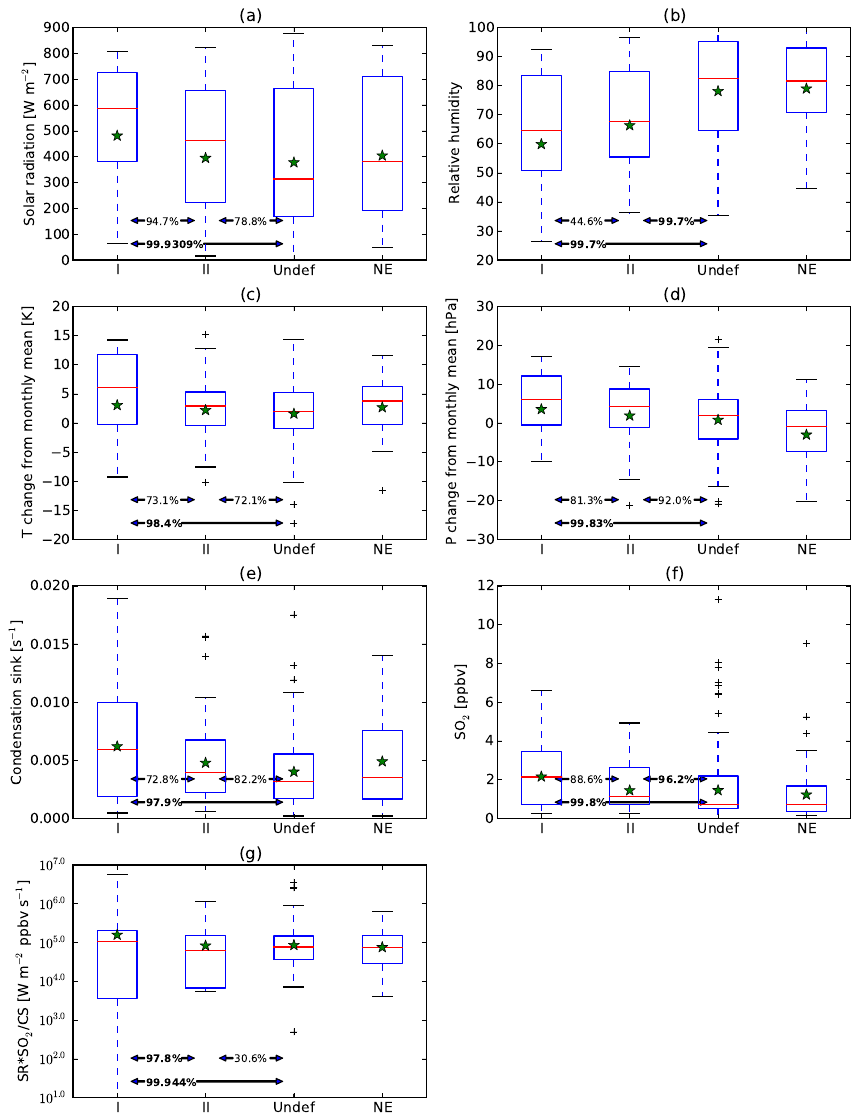
Figure 4. Box-and-whisker plots of various meteorological variables as well as the condensation sink, SO 2 mixing ratio and a H 2 SO 4 proxy for class I, II, undefined and non-event days. The values are calculated between the start and end of new-particle formation on each day except for non-event days where the full day is used. The red line shows the median values. Stars show the mean values. The box shows the interquartile range (IQR, 25th and 75th percentiles). The whiskers show the lowest datum still within the 1.5 IQR of the lower quartile, and the highest datum still within the 1.5 IQR of the upper quartile. Crosses show data outside of the 1.5 IQR above or below the upper or lower quartile. The percentages shown in between each box show the probability that the distributions are statistically different (calculated using the Mann–Whitney U test). Although not shown on the plots, the distributions for Ia days are statistically different from non-event days to at least the 98% level for all factors except condensation sink (89%). Panel (a) solar radiation, (b) relative humidity, (c) temperature change from the running 28-day mean (14 days before to 14 days after, to remove the seasonal cycle), (d) surface pressure change from the running 28-day mean, (e) condensation sink, (f) SO 2 mixing ratio, (g) H 2 SO 4 proxy (SR · SO 2 / condensation